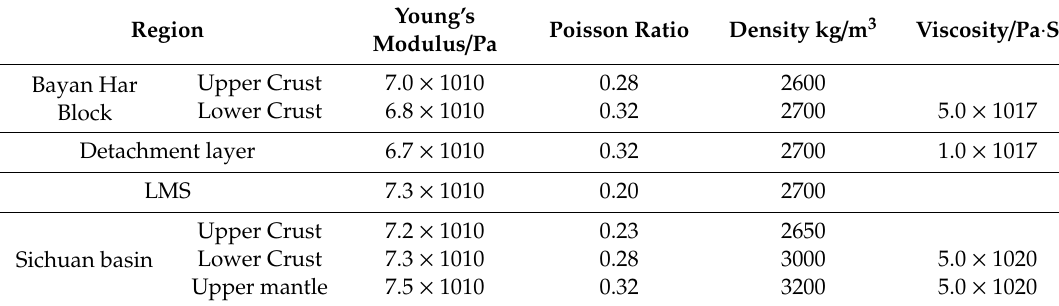
Table 1. Parameters in the